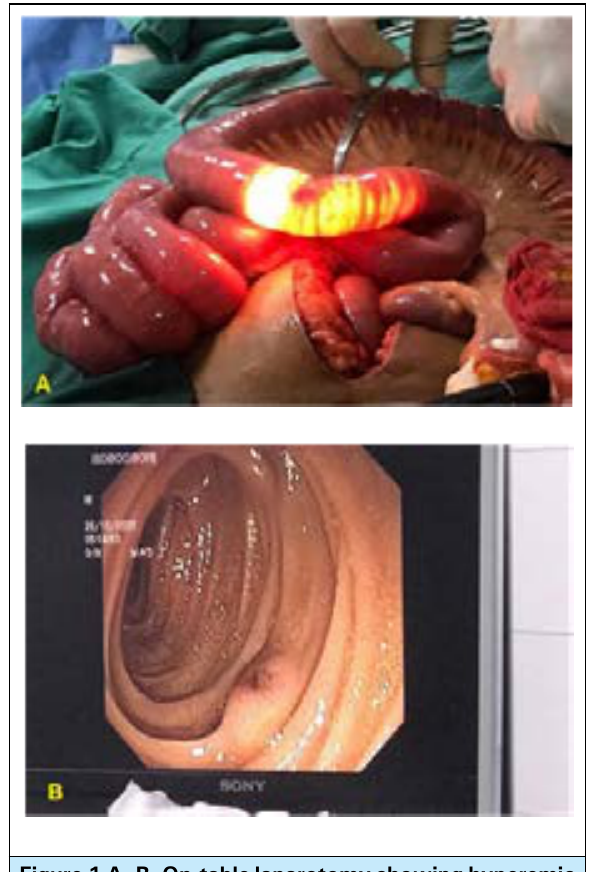
Figure 1 A, B. On-table laparotomy showing hyperemic area in the wall of bowel and enteroscopy (showing a bright red elevated area in the proximal